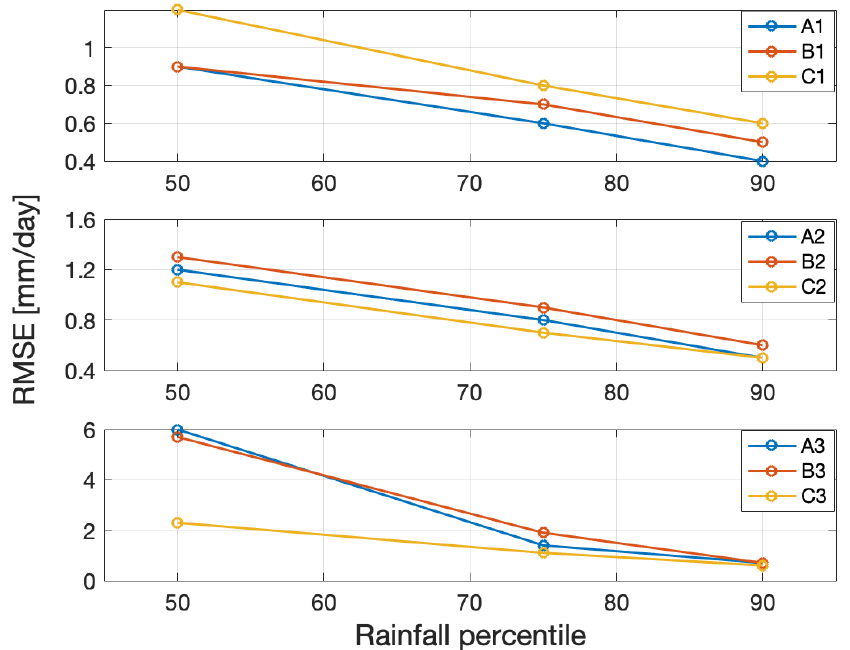
Figure 15. Line plots showing the model RMSE value for 50th, 75th and 90th percentiles rainfall over all boxes. The model RMSE decreases with increasing rainfall percentile. That is, at higher rainfall percentiles, the model provides better constrained values and is likely a more realistic atmospheric-process explanation than at lower rainfall